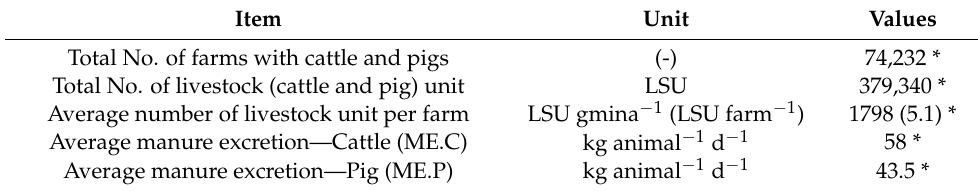
Table 2. Structure of livestock farms and coefficients for manure